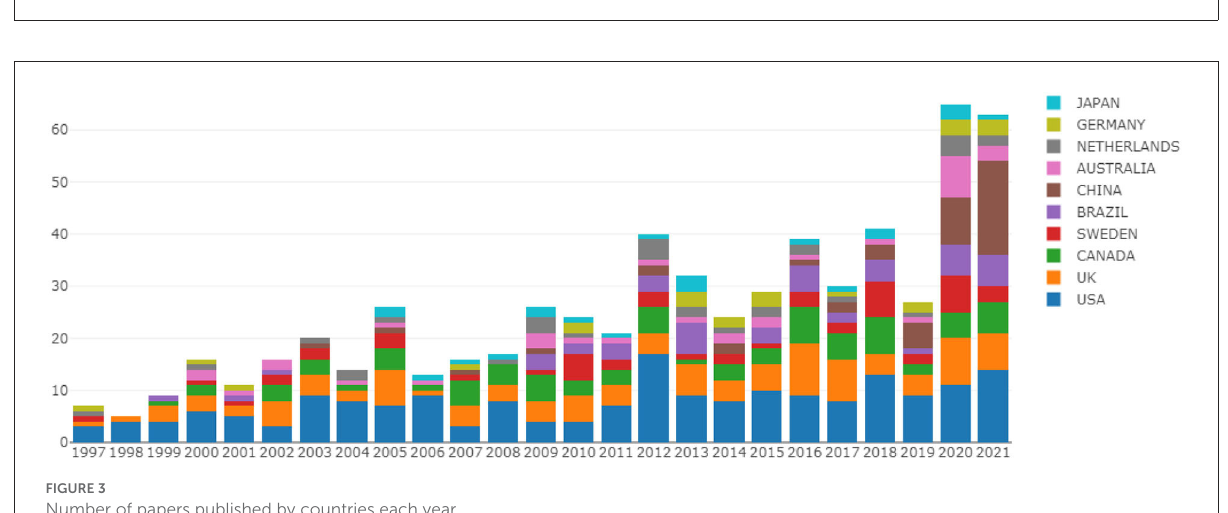
FIGURE2 Dual-map overlay of literature on income inequality and health research.